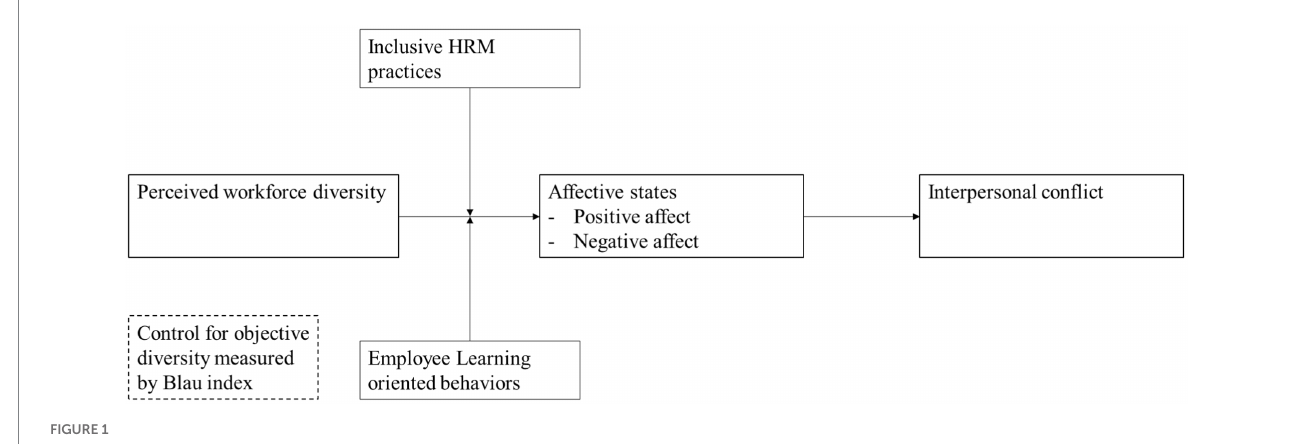
FIGURE 1 Conceptual